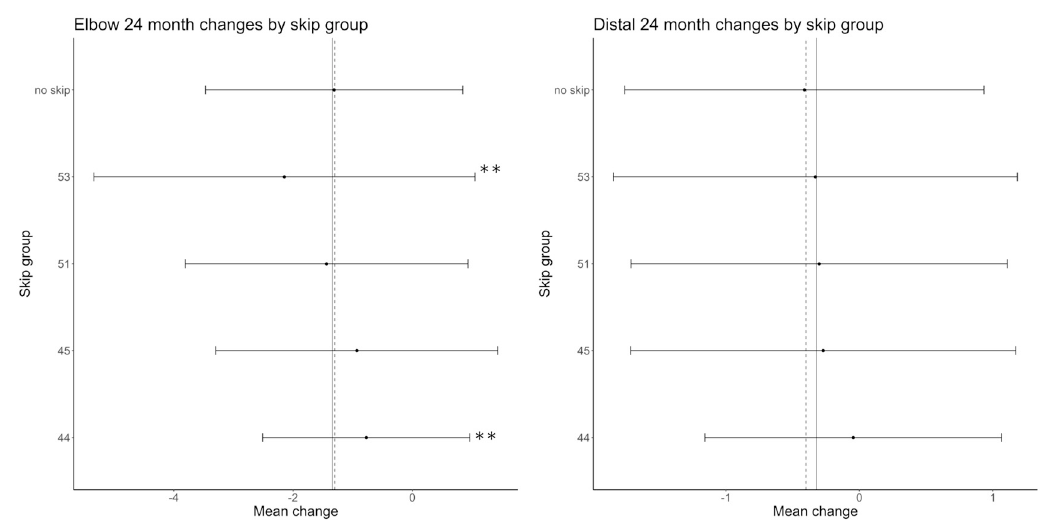
Figure 1. Details of mean changes and SD of the individual exon classes in relation to the mean changes in the whole DMD cohort (vertical dashed line) and in the groups including all deletions (vertical solid line). ** = significant difference from the mean changes of all deletions.